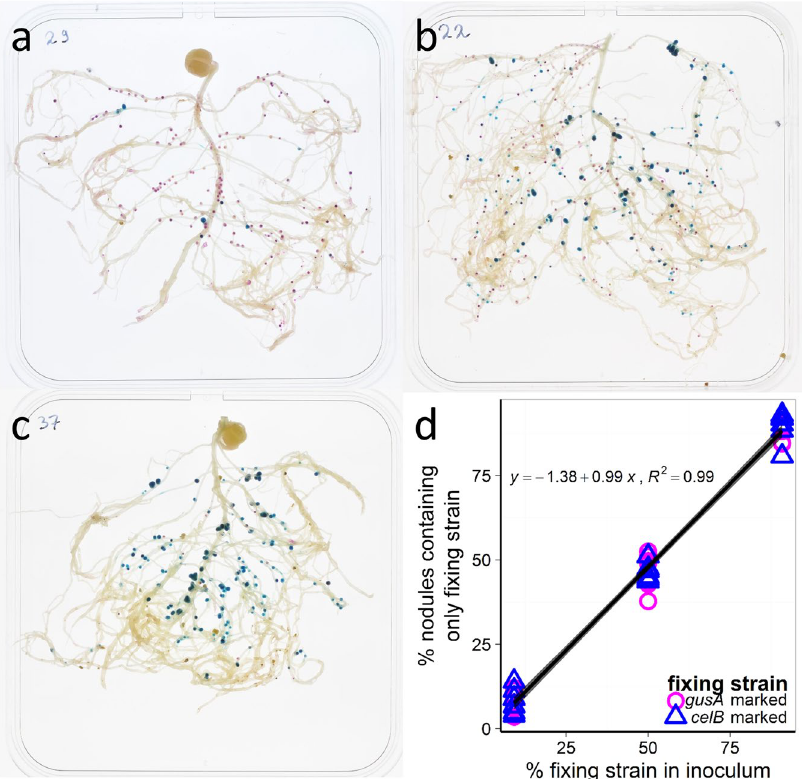
Figure 2. We found no evidence of partner choice. ( a – c ) show pea root systems with stained nodules following inoculation with different ratios of a fixing celB (blue) marked strain (3841 celB ) and a non-fixing gusA (magenta) marked mutant strain (OPS0365): ( a ) 1:10 (fixing:non-fixing); ( b ) 1:1 (fixing:non-fixing); ( c ) 10:1 (fixing:non-fixing). ( d ) The percentage of nodules containing only the fixing strain exactly reflected the percentage of the fixing strain in the inoculum. The slope of the regression was 0.99 ± 0.02, 95% CI [0.95, 1.02] and this is not significantly different from one ( t 39 = − 0.835, p =